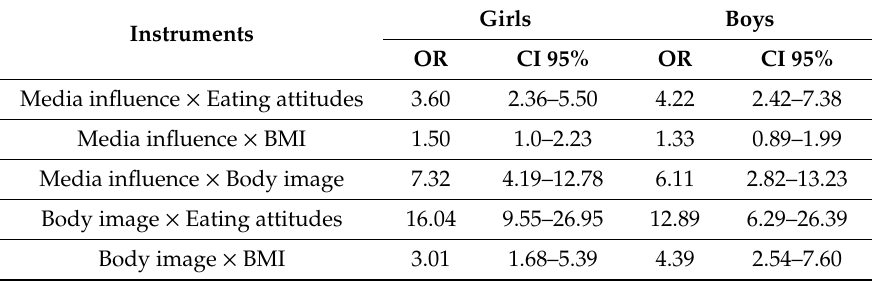
Table 4. Odds ratio (OR) for the relation between SATAQ-3 and other variables, and EAT-26 and other variables.